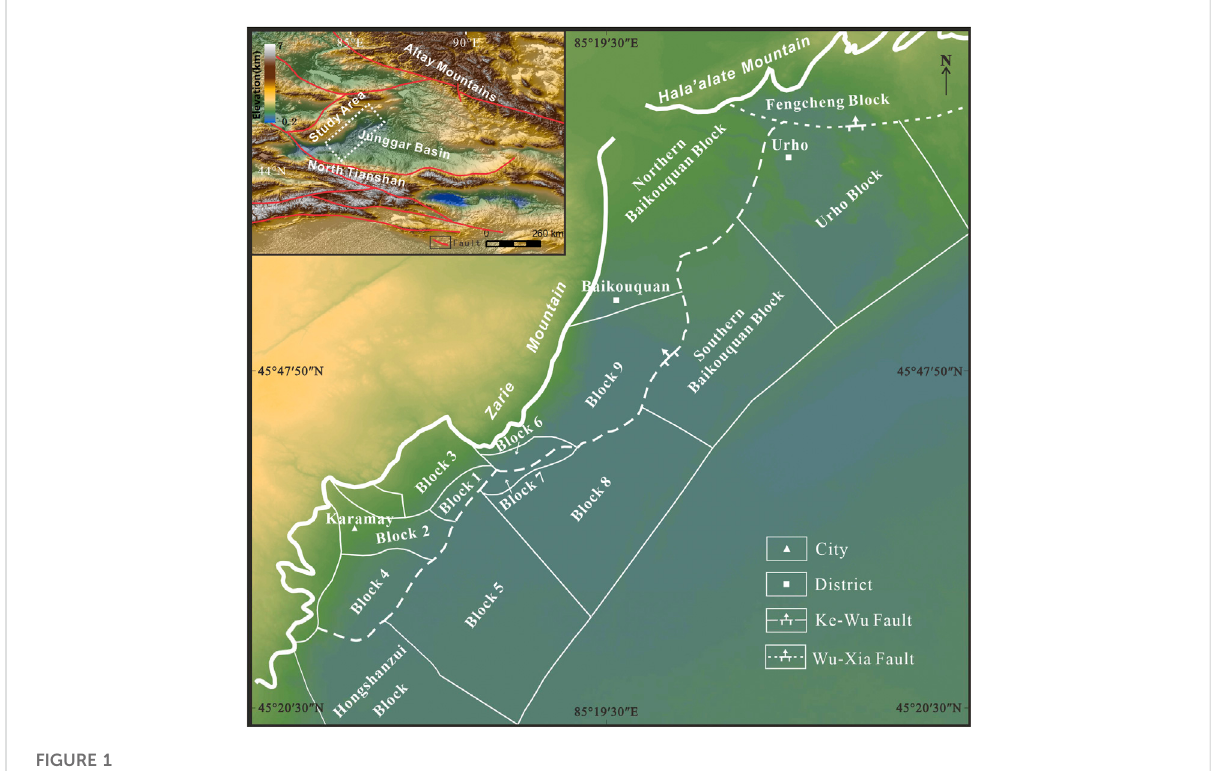
FIGURE 1 Geographic location of the study